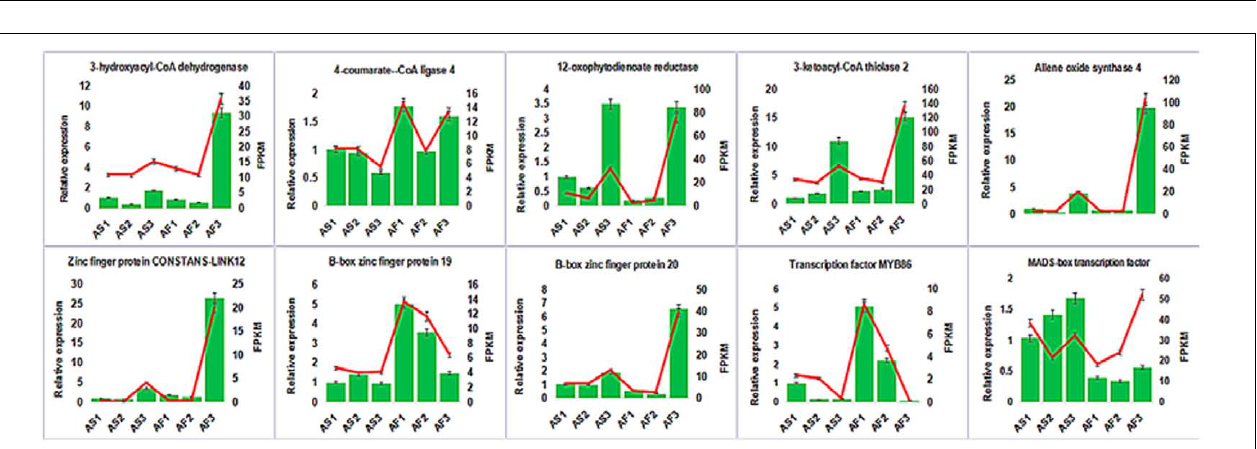
FIGURE 11 | Candidate DEGs expression levels revealed by qRT-PCR (histogram) and RNA-seq (line chart). Data from qRT-PCR are means of three replicates and bar represent SE. RPKM from RNA-seq data.